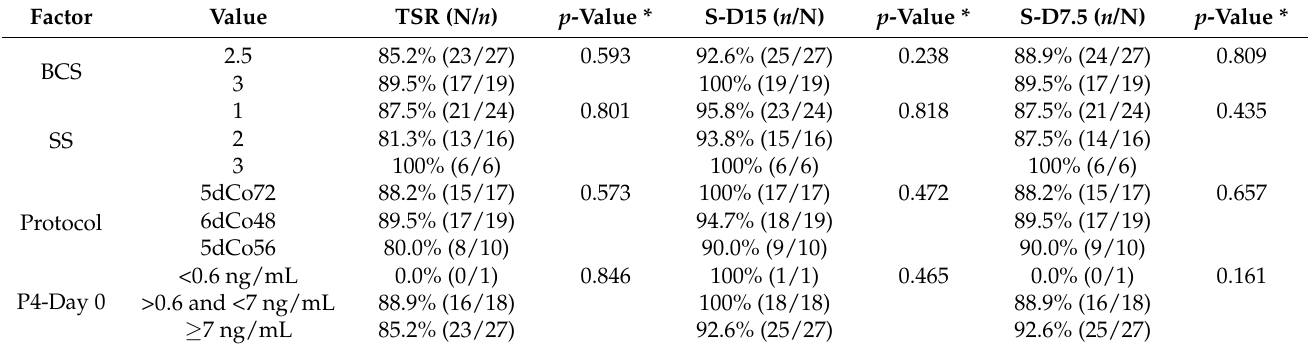
Table 3. Summary of synchronization results of dairy heifers in experiment 1 by synchronization